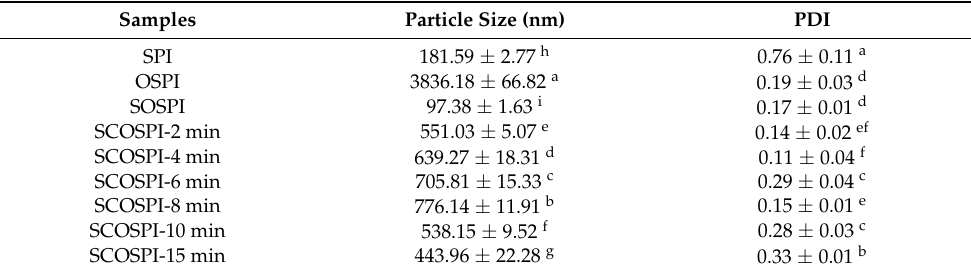
Figure 2. SEC profiles of natural, oxidized soybean protein, and cavitation jet treated on soluble soybean protein oxidized accumulates at several times (2, 4, 6, 8, 10, and 15 min). Table 1. Particle size and protein dispersibility index (PDI) of natural, oxidized soybean protein, and cavitation jet treated on soluble soybean protein oxidized accumulates at several times (2, 4, 6, 8, 10, and 15 min).